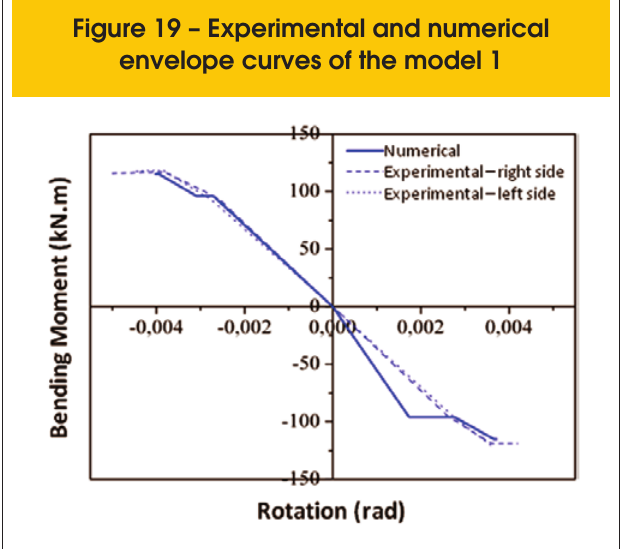
Figure 19 – Experimental and numerical envelope curves of the model